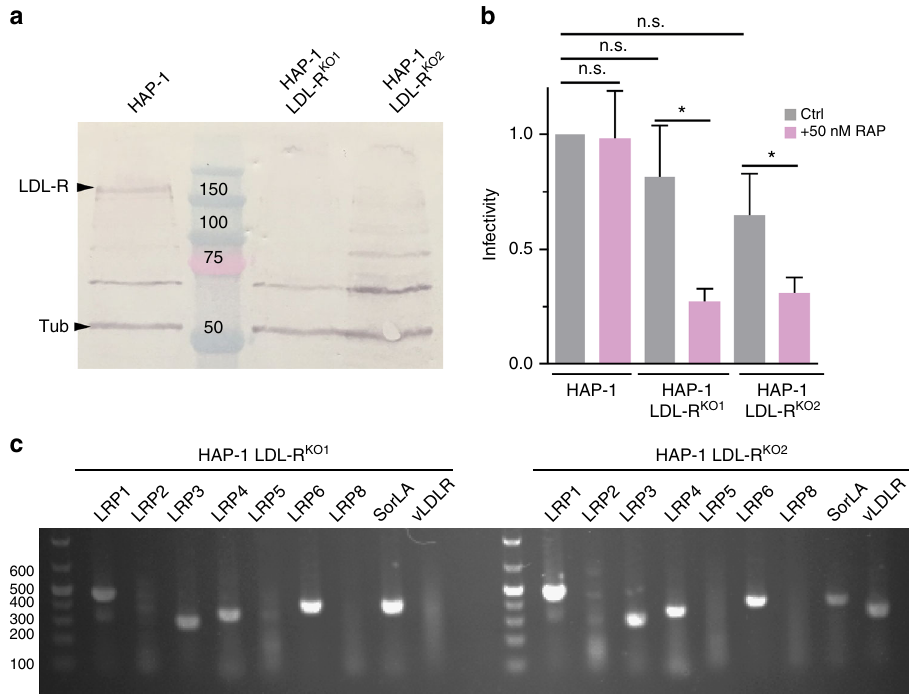
Fig. 6 LDL-R presence on the cell surface is not mandatory for VSV infection. a Analysis of LDL-R expression in wild-type HAP-1, HAP-1 LDL-R KO1 and HAP-1 LDL-R KO2 cells. The immunoblot was performed on crude cell extracts and revealed with chicken anti LDL-R (GW22458A from Sigma). α -Tubulin (tub) was also immunoblotted as a loading control. The LDL-R band migrates with an apparent MW of 150 kDa due to the presence of glycosylation sites (predicted MW without oligosaccharides is 95 kDa). b Effect of the RAP protein on the susceptibility of LDL-R de fi cient HAP-1 cells to VSV-eGFP infection. VSV-eGFP was used to infect HAP-1 and HAP-1 LDL-R KO cells in the presence or not of RAP (50 nM). Infectivity was determined by counting the number of cells expressing eGFP using a fl ow cytometer. Data depict the mean with standard deviation for experiments performed in triplicate. p values were determined using an unpaired Student's t test (* p < 0.05; n.s. non-signi fi cant). c Expression of LDL-R family members in HAP-1 LDL-R KO cell lines evaluated by